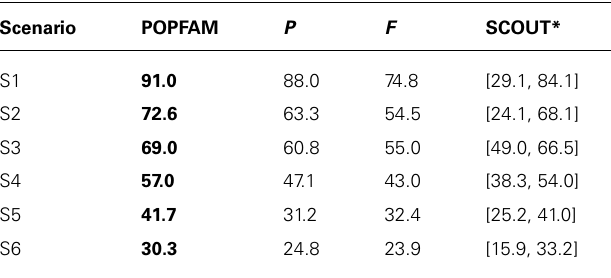
Table 3 | Power (%) to detect an